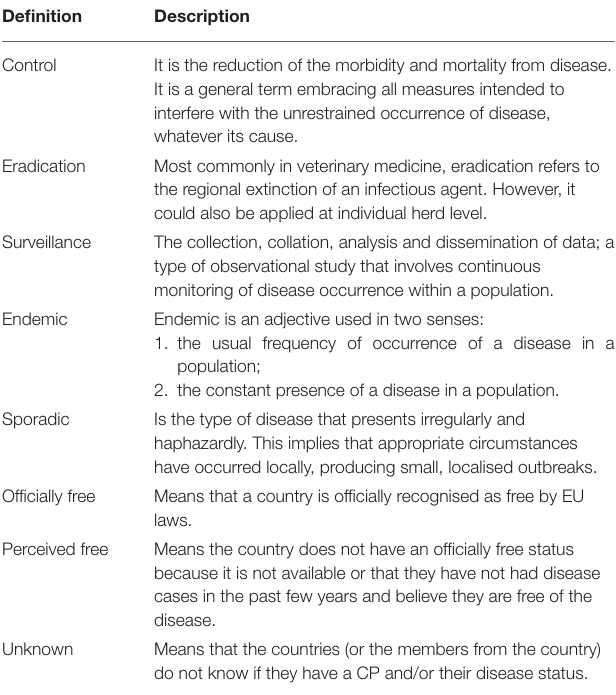
TABLE 1 | Definitions for terms used to describe type of control programme (CP) and country status for disease in this survey of CPs among countries in